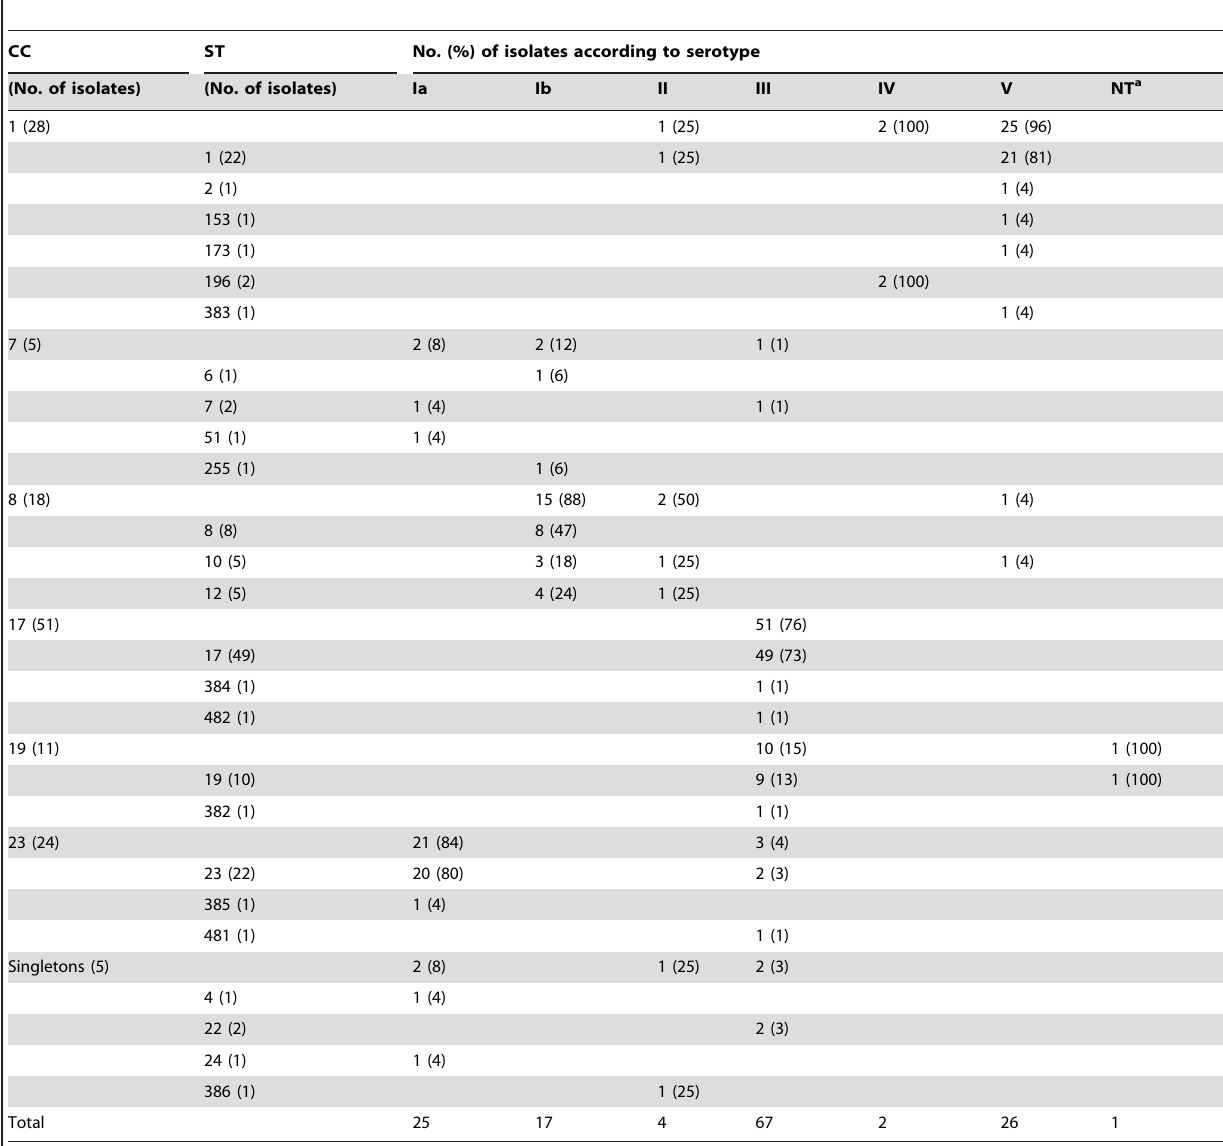
Table 3. Serotype of S. agalactiae isolates from the various STs and CCs implicated in adult and neonatal invasive infections.